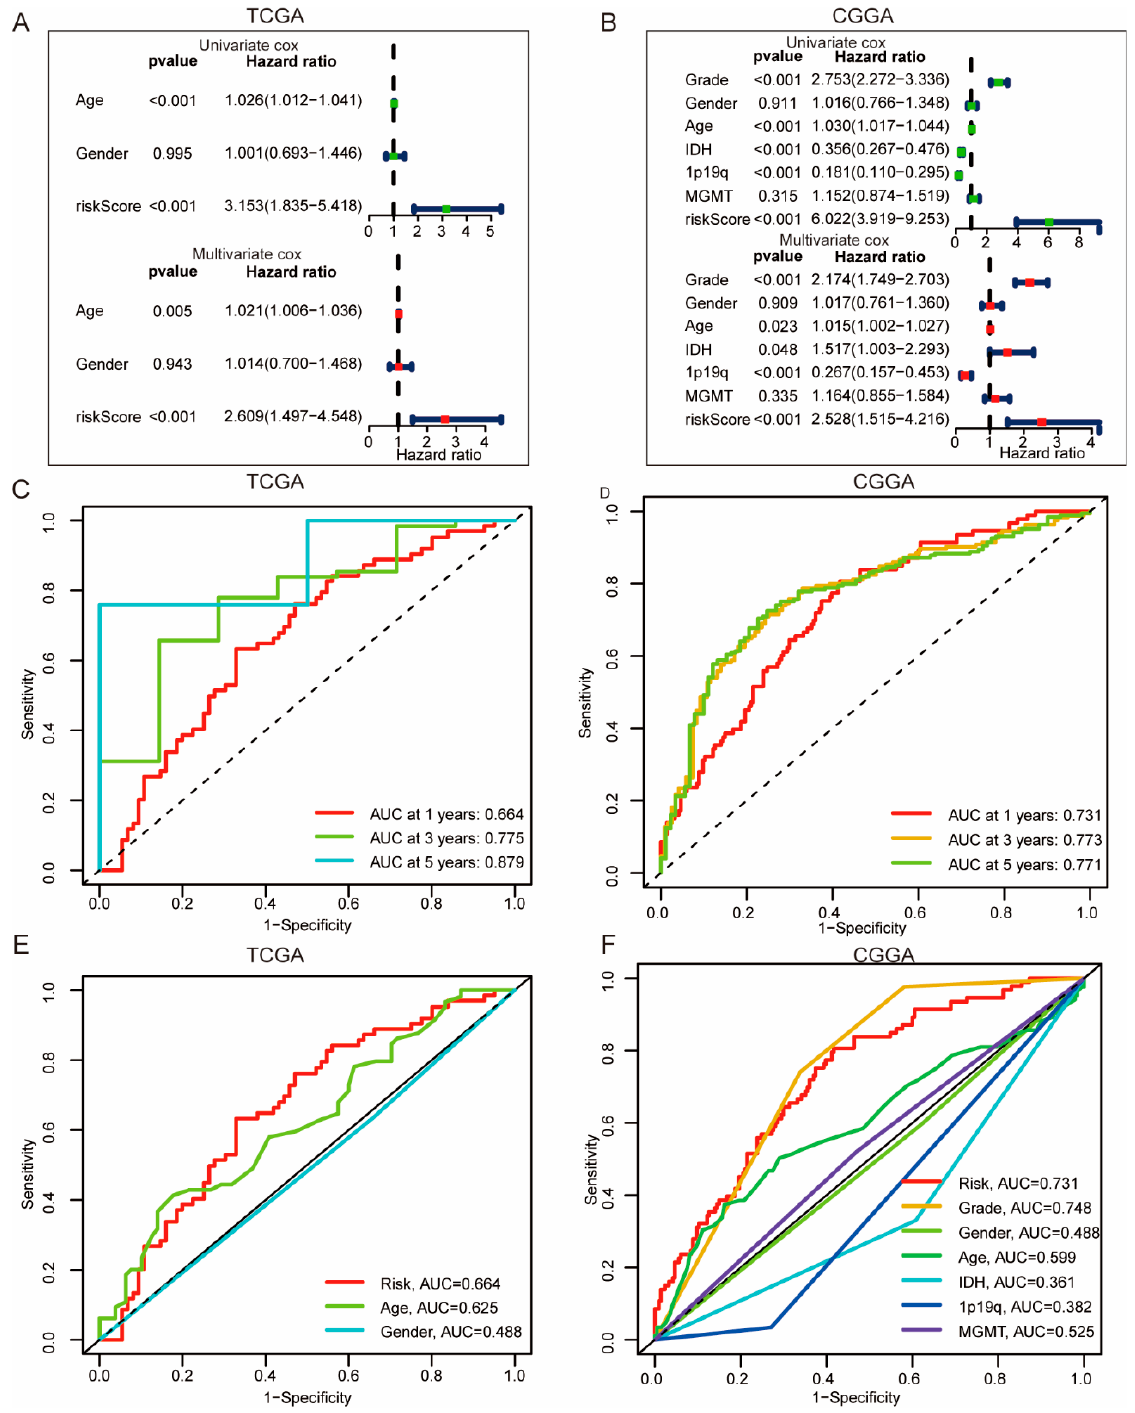
Figure 7. The prognostic value of ICD prognostic signature model in TCGA and CGGA database. The independent prognostic value of ICD risk signature by univariate and multivariate Cox analysis in TCGA ( A ) and CGGA ( B ) database. One-, three- and five-year ROC curves of prognostic value in TCGA ( C ) and CGGA ( D ) database. ROC curves of ICD prognostic risk score, age and grade in TCGA ( E ), and ICD prognostic risk score, age, grade pathological grade, IDH mutation, 1p19q co-deletion and MGMT methylation in CGGA ( F ) database.